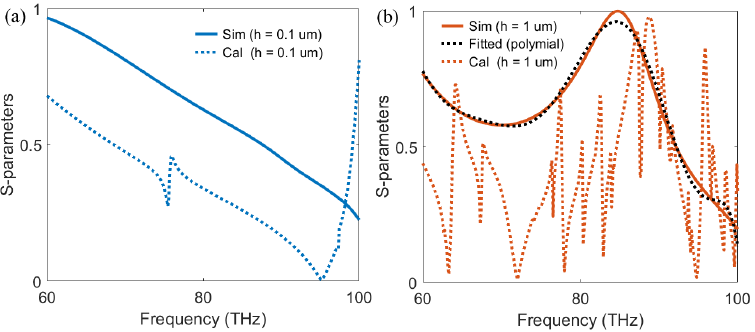
Figure 6. Cascade response of multiple mixed cascade responses of the transparent substrate and the metal film. Among them, the black dot line graph is the 8th degree polynomial fitting of the simulation results. ( a ) The thickness is 0.1 um (single layer); ( b ) The thickness is 1 um (ten layers).